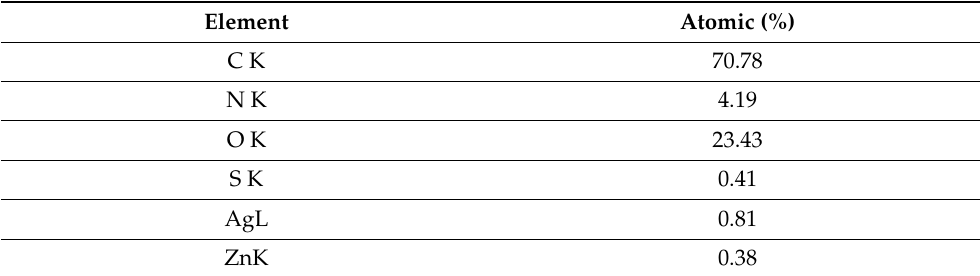
Figure 3. Scanning electron microscope (SEM) micrographs of ( A ) Ag 2 O/CA with 1 µ m scale bar, ( B ) Ag 2 O/CA with 5 µ m scale bar, ( C ) particle distribution of Ag 2 O/CA, ( D , E ) Ag 2 O/ZnS/CA with 1 and 5 µ m scale bar and particle distribution, ( F ) particle distribution of Ag 2 O/ZnS/CA, ( G , H ) Ag 2 O/ZnS/GO/CA with 1 and 5 µ m scale bar and particle distribution, and ( I ) particle distribution of the embedded Ag 2 O/ZnS/GO on CA film. Table 2. The quantification analysis of EDX is based on SEM